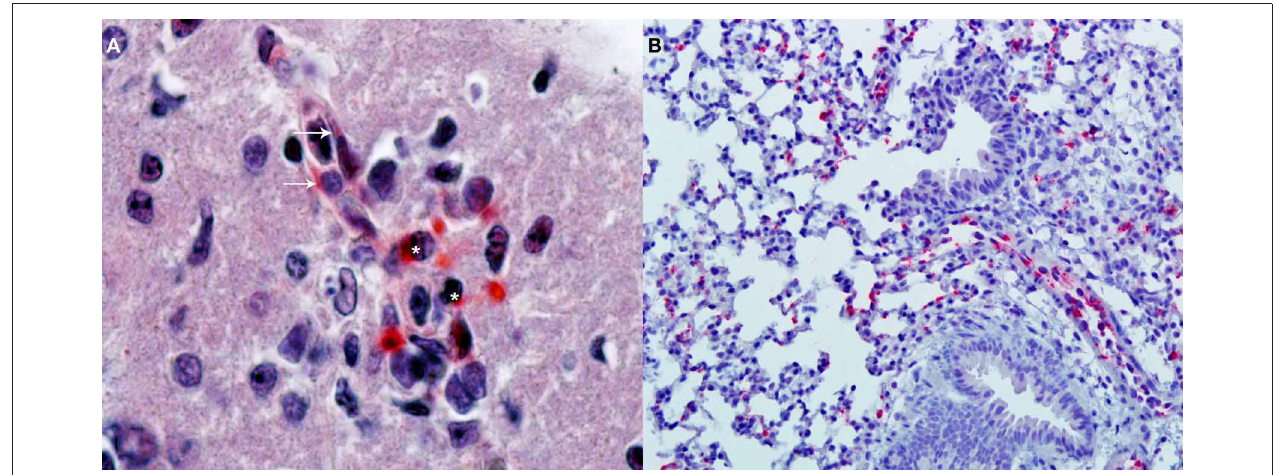
FIGURE 2 | Immunohistochemical detection of oriential antigen. (A) Analysis performed in the brain of a C3H/HeN mouse infected i.v., with 2 × 10 5 FFU of Orientia tsutsugamushi 11 days earlier (original magnification 400 × ). Alkaline phosphatase signal from the secondary antibody produces a red precipitate visible in endothelial cells of a